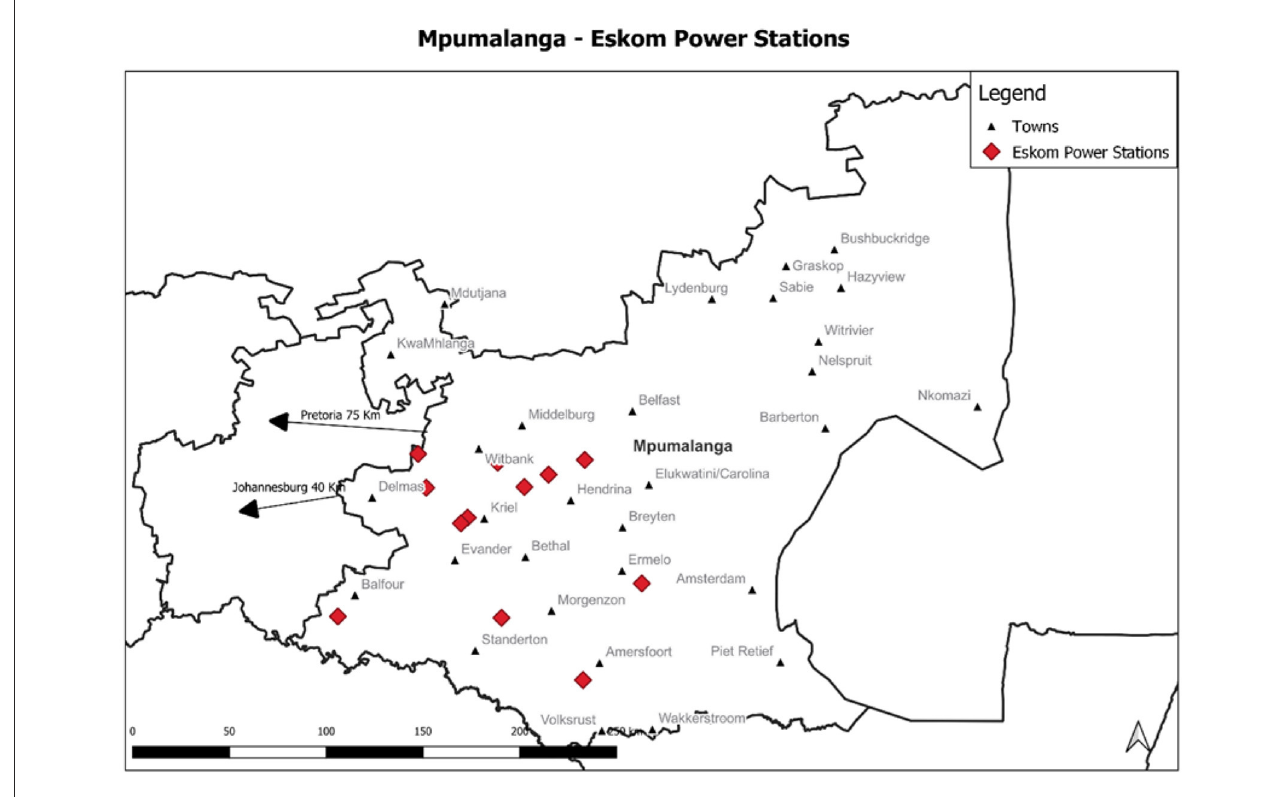
FIGURE1 Coal-fire stations in Mpumalanga,